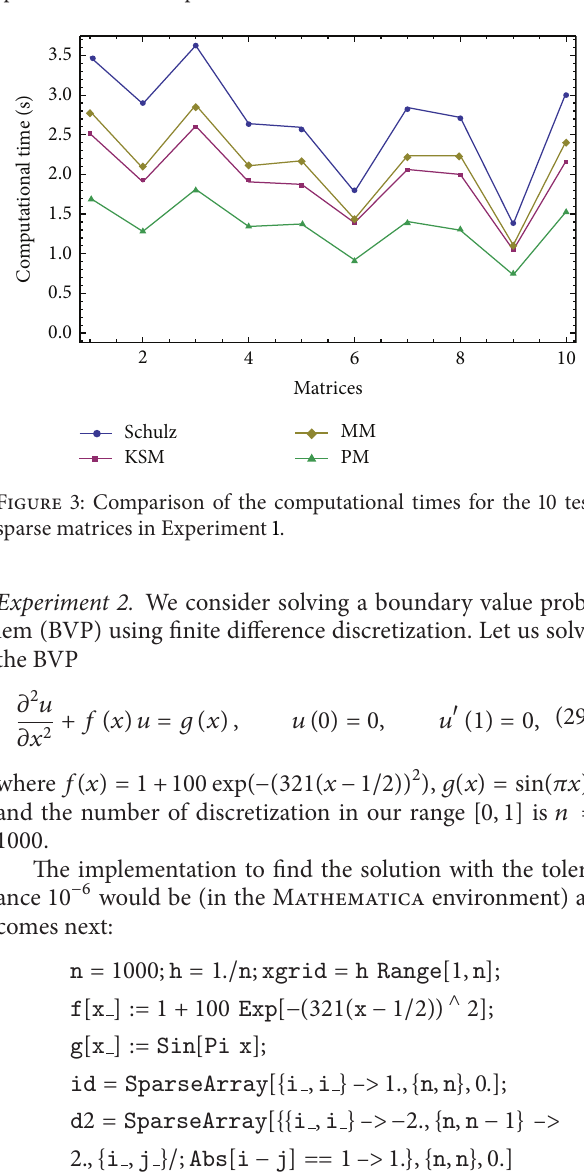
Figure 2: Comparison of the number of iterations for the 10 test sparse matrices in Experiment 1.